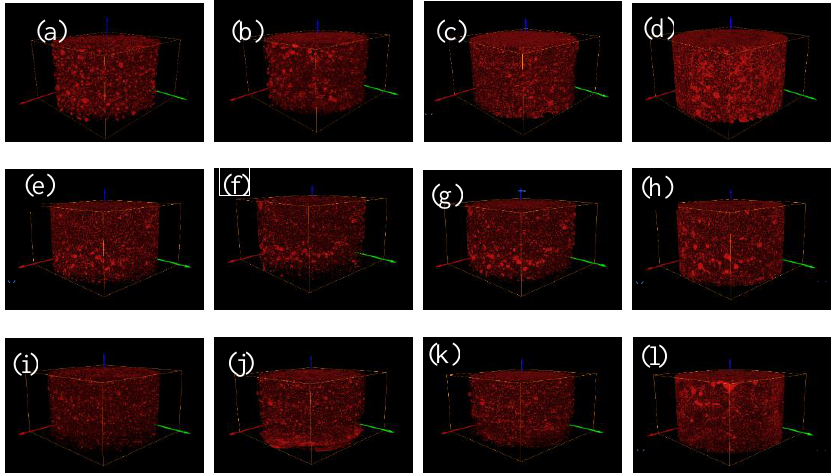
Figure 7. The overall pore structure of the three fine-grained tailings sand samples. ( a ) First-level head of 30% fine content; ( b ) Second-level head of 30% fine content; ( c ) Third-level head of 30% fine content; ( d ) Fourth-level head of 30% fine content; ( e ) First-level head of 50% fine content; ( f ) Second-level head of 50% fine content; ( g ) Third-level head of 50% fine content; ( h ) Fourth-level head of 50% fine content; ( i ) First-level head of 70% fine content; ( j ) Second-level head of 70% fine content; ( k ) Third-level head of 70% fine content; ( l ) Fourth-level head of 70% fine content.